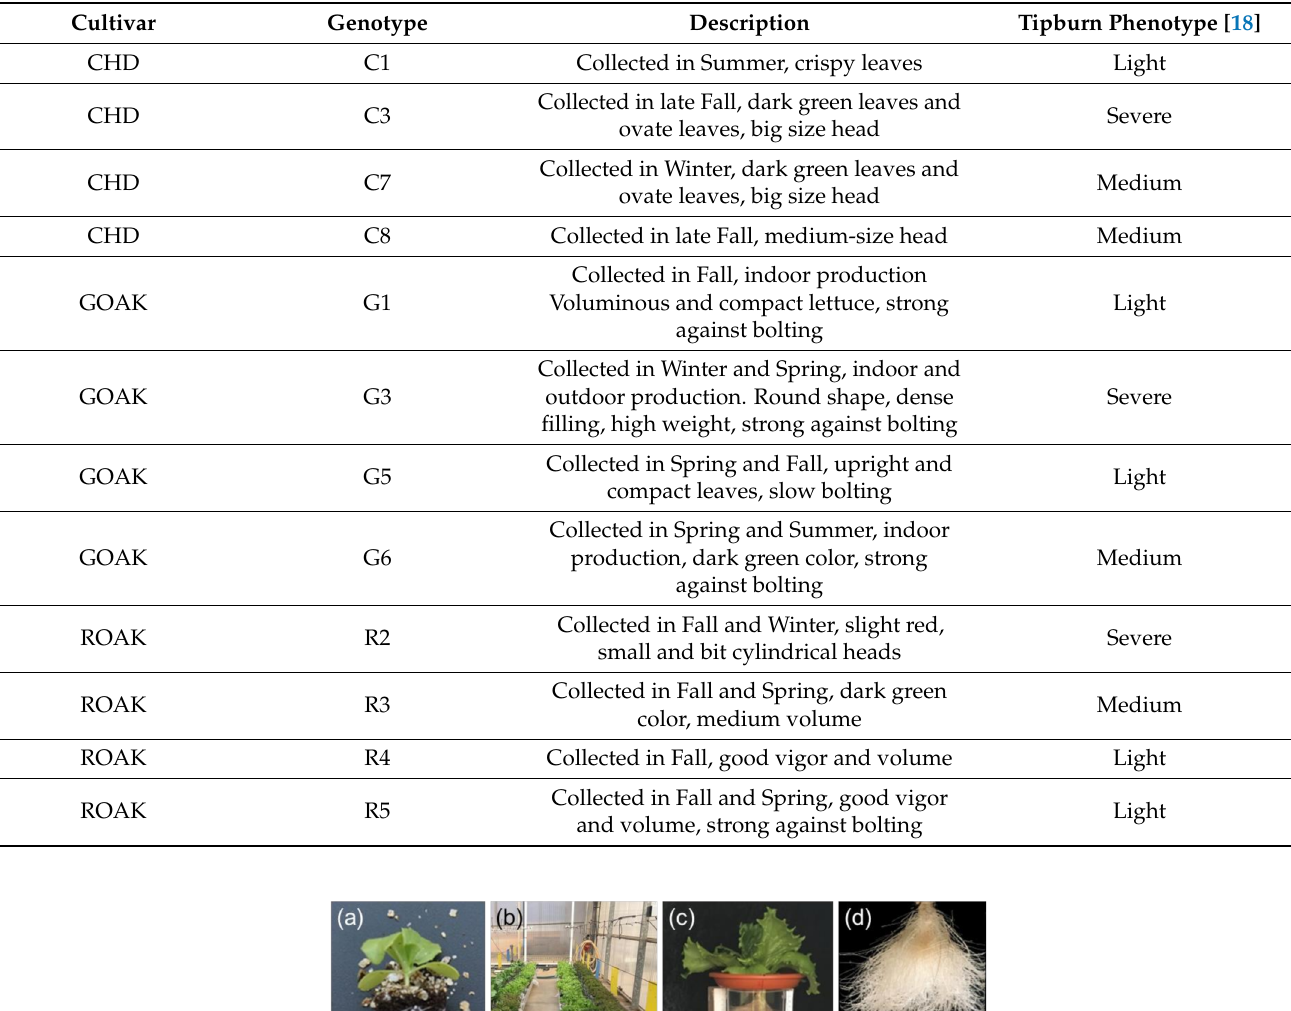
Table 1. Some details of the lettuce genotypes used in this study.